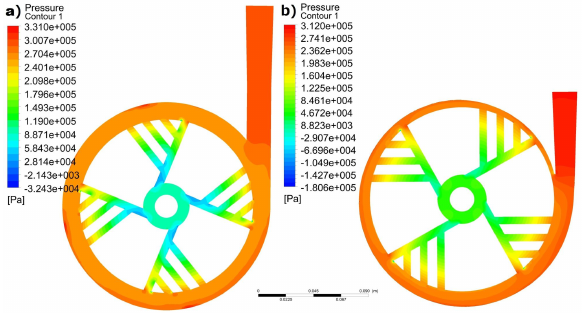
Figure 20: Distribution of static pressure on the model central plane